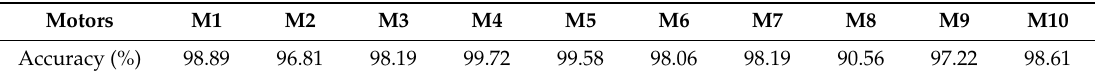
Table 6. Accuracy of correctly identifying individual signals.